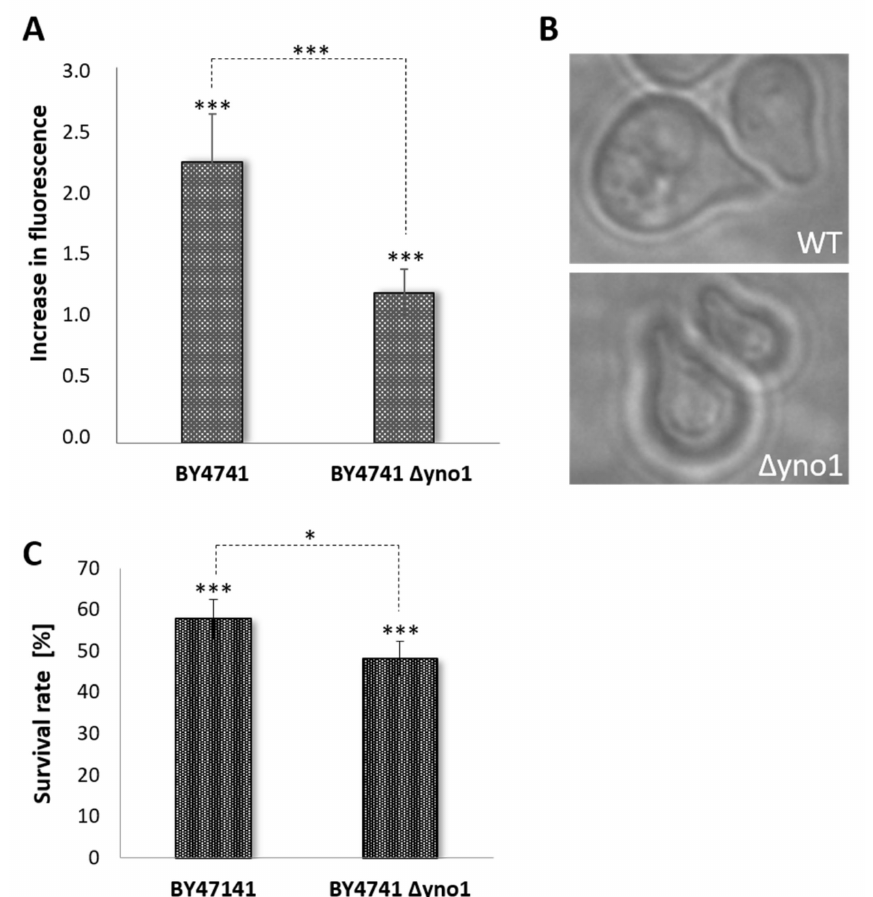
Figure 5. The role of Yno1p in pheromone response. ( A ) DHE fluorescence was analyzed in the strains BY4741 and BY4741 ∆ yno1 in untreated controls as well as after addition of alpha factor (100 µ g/mL) (N = 8). In ( B ), differential interference contrast microscopy images of shmoos in the BY4741 and BY4741 ∆ yno1 background are shown after addition of alpha factor (100 µ g/mL). In ( C ), the survival rate in the strains BY4741 and BY4741 ∆ yno1 was calculated by survival plating. Cell death was induced by addition of alpha factor (100 µ g/mL). In untreated cells (BY4741 and BY4741 ∆ yno1 ), no difference in survival was observed. For ( A , C ): each bar represents the comparison between untreated and treated yeast strains (either BY4741 or BY4741 ∆ yno1 ), asterisks above the bars indicate statistical significance between with/without treatment, asterisks above the brackets represent statistical significance between the different yeast strains (BY4741 and BY4741 ∆ yno1 ) upon treatment with alpha-factor (*: p < 0.1; ***: p <